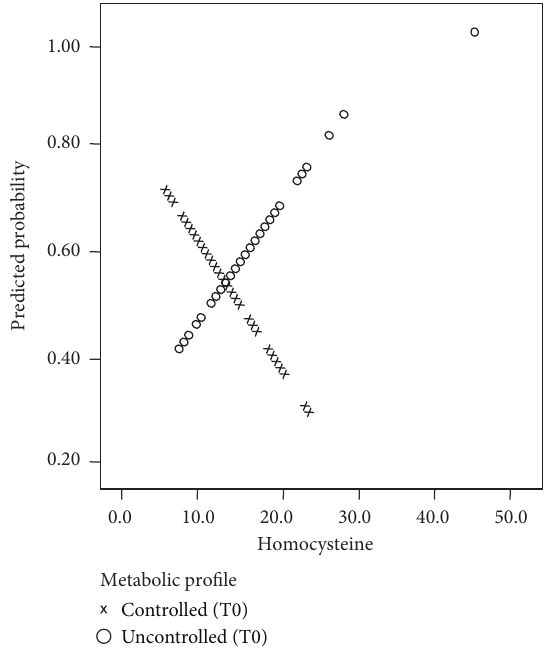
Figure 4: Predicted probability of frequent fatigue by homocysteine levels and metabolic